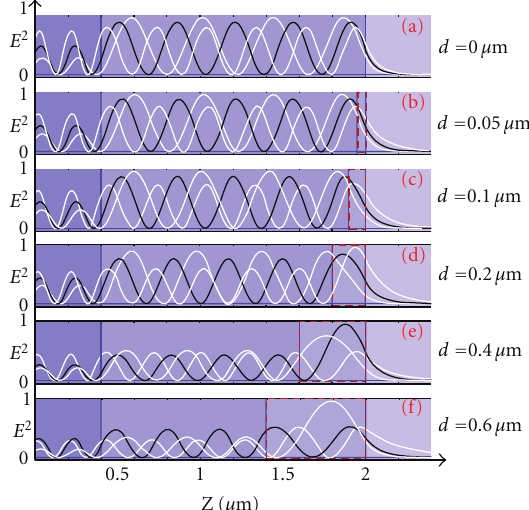
Figure 12: The vertical high-order modes profiles of the OLEDs structure with surface PhCs. The region in the red rectangle is the PhCs layer.